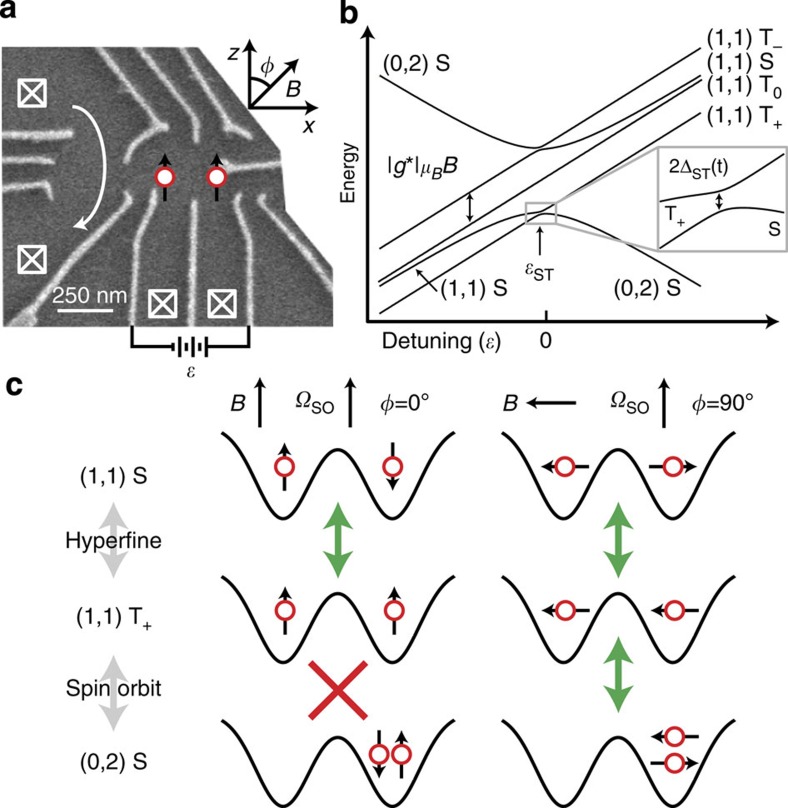
Experimental set-up.(a) Scanning electron micrograph of the double quantum dot. A voltage difference between the gates adjusts the detuning ɛ between the potential wells, and a nearby quantum dot on the left senses the charge state of the double dot. The gate on the right couples the double dot to an adjacent double dot, which is unused in this work. The angle between B and the z axis is ϕ. (b) Energy level diagram showing the two-electron spin states and zoom-in of the S−T+ avoided crossing. (c) The hyperfine interaction couples |(1,1)S〉 and |(1,1)T+〉 when the two dots are symmetric, regardless of the orientation of B, and the spin–orbit interaction couples |(0,2)S〉 and |(1,1)T+〉 when B has a component perpendicular to , the effective spin–orbit field experienced by the electrons during tunnelling.